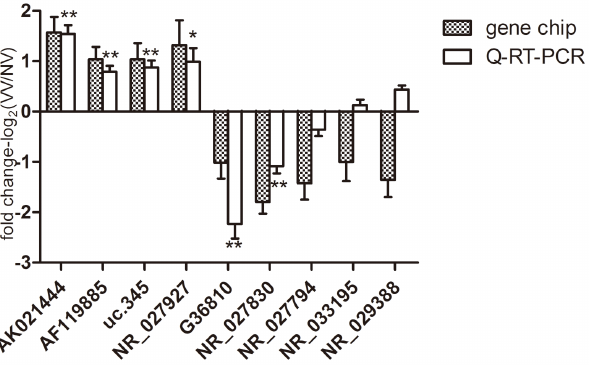
Figure 1. Validation of microarray data and the Q-RT-PCR data. Nine lncRNAs were chosen for validation in 32 pairs of VVs samples compared with NVs samples by Q-RT-PCR. seven of the nine lncRNAs showed the same trends with respect to up- or down- regulation as the microarray data and six lncRNAs (AK021444, AF119885, G36810, uc.345, NR_027927 and NR_027830) showed statistically significant differences ( P , 0.05). The heights of the columns in the chart represent the mean expression value of log2 fold changes (VVs/NVs) for each of the nine validated lncRNAs in the microarray and Q-RT-PCR data; The bars represent standard errors. The validation results indicated that the microarray data were closely correlate with the Q-RT-PCR results. *: P , 0.05, **: P , 0.01. PLOS ONE |